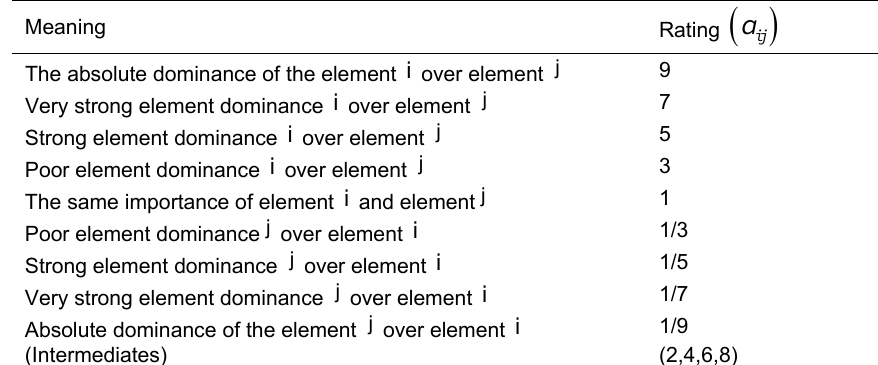
Table 1 – Saaty rating scale T аблица 1 – Оценочная шкала